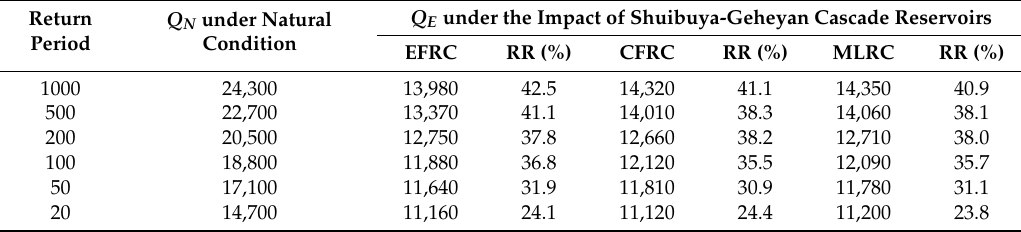
Table 7. Design peak discharges at Gaobazhou site with different return periods under the impact of Shuibuya-Geheyan cascade reservoirs operation (m 3